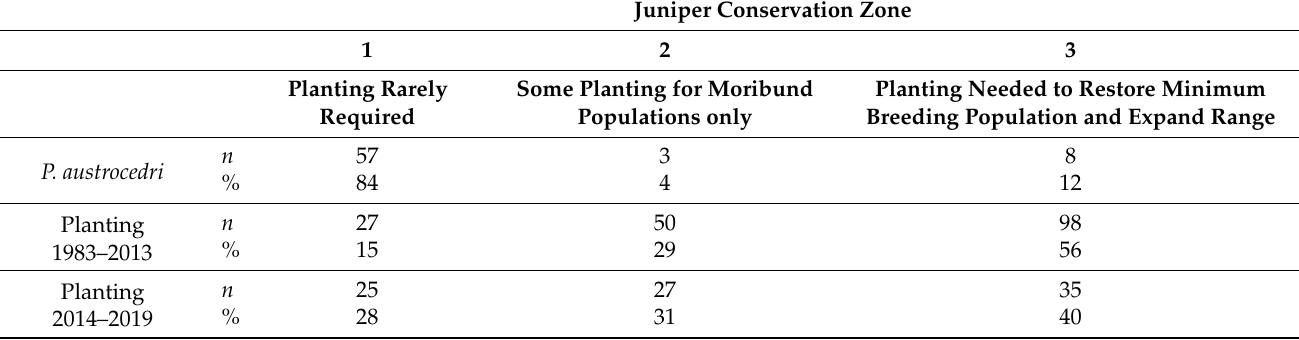
Table 6. Number ( n ) and percentage (%) of juniper tetrads associated with positive P. austrocedri detections and planting events during 1983–2013 and 2014–2019 (before and after publication of the most recent planting guidance) in Scottish juniper conservation